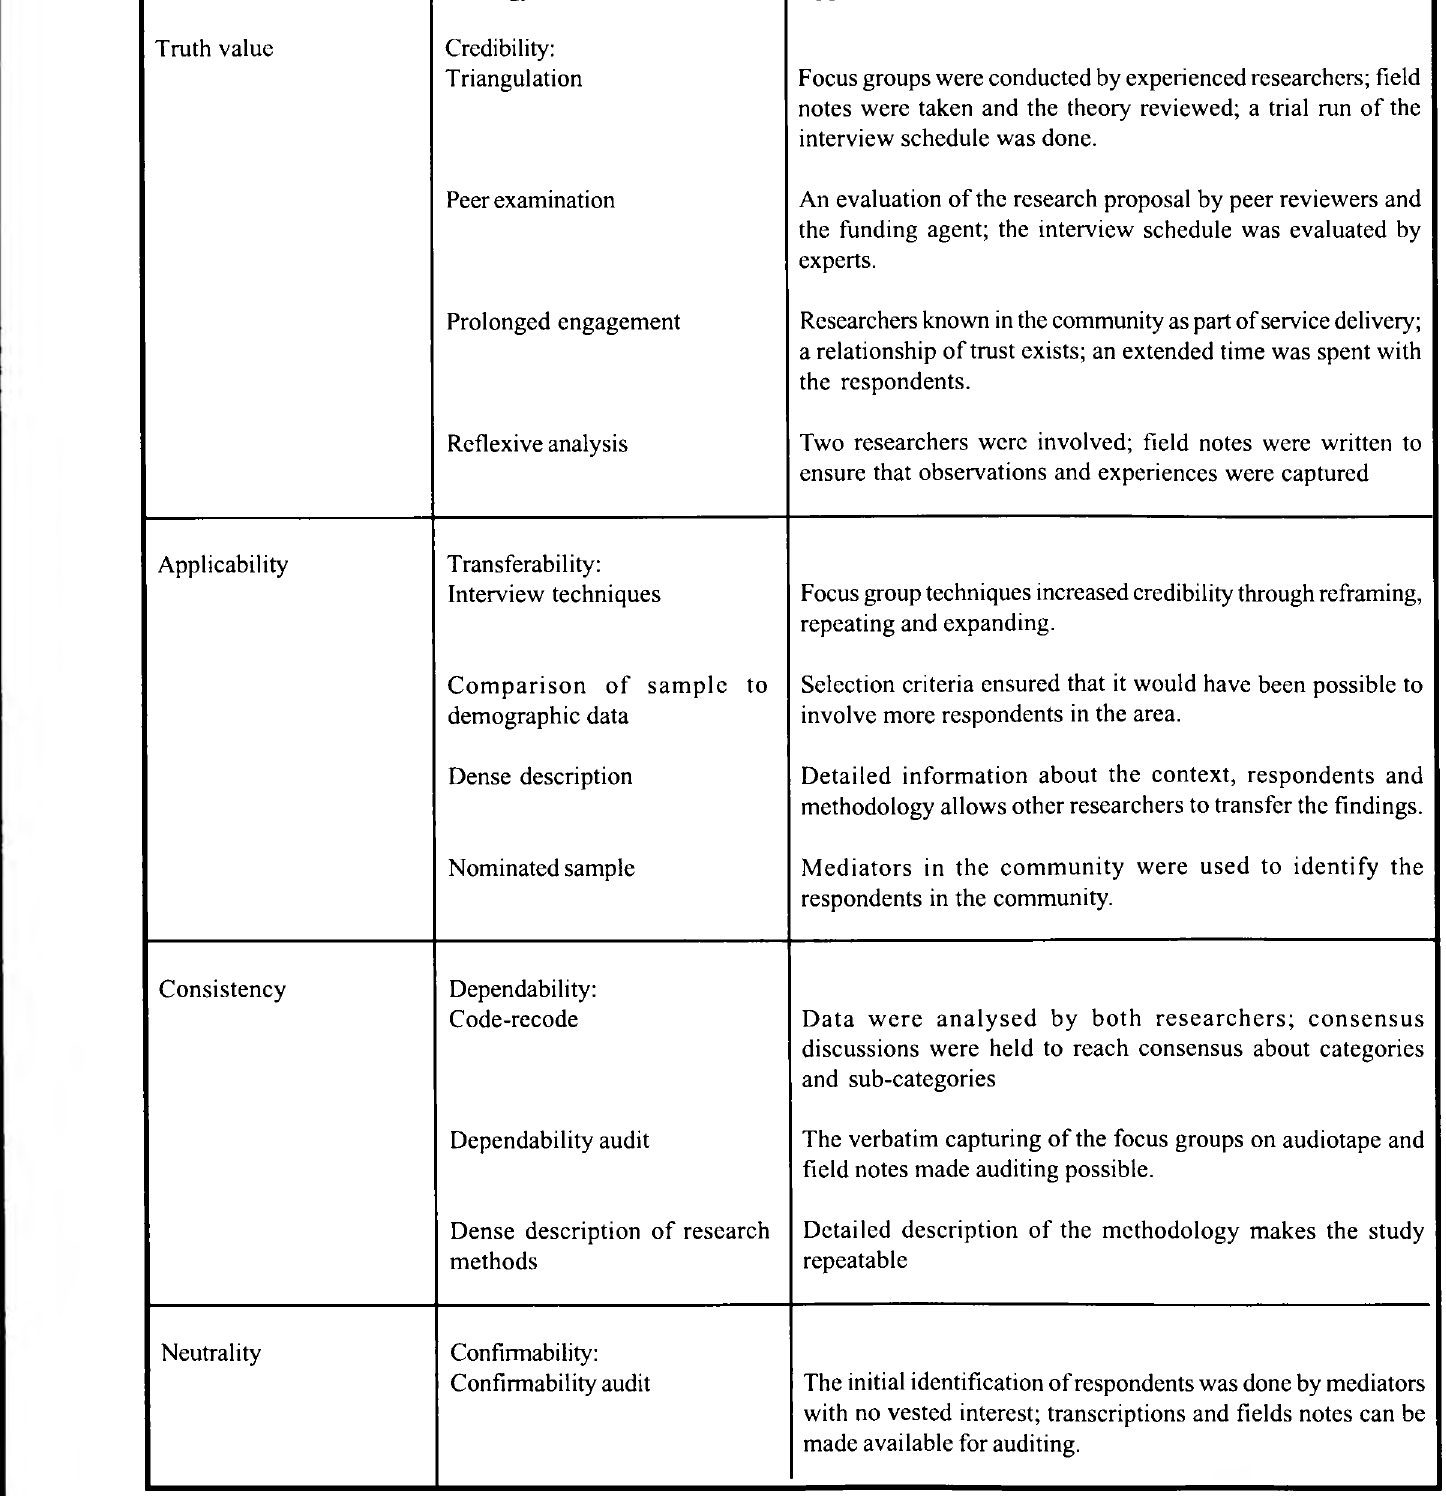
Table 2: Trustworthiness of the research Criteria Strategy Application Truth